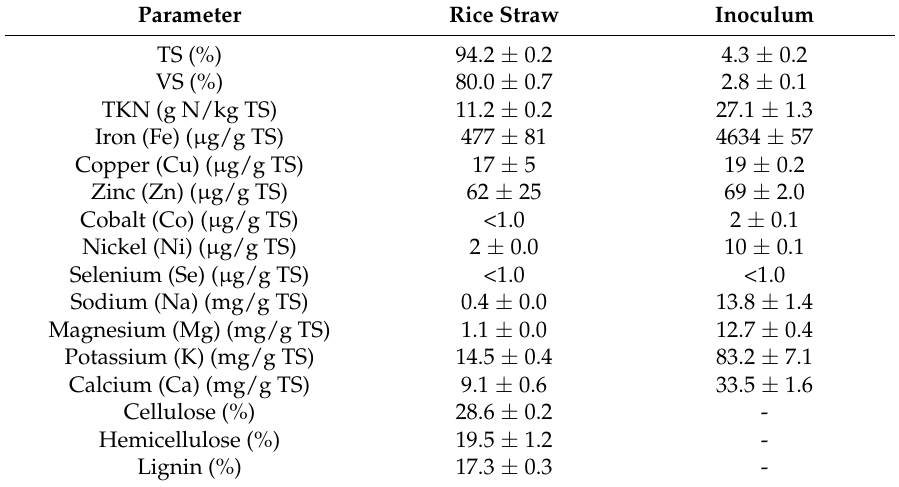
Table 1. Physicochemical characterization of the rice straw and inoculum used in the BMP tests in terms of solids, nitrogen, trace elements, and lignocelluloses. Analyses were performed in triplicate. Parameter Rice